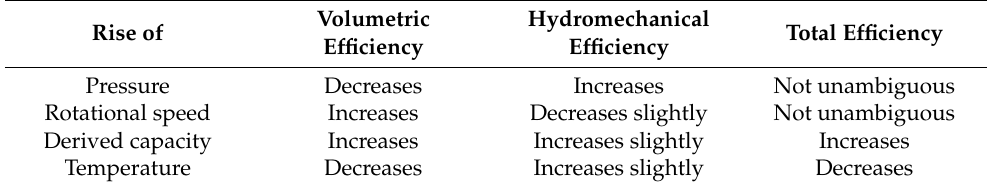
Table 4. Rough generalization of empirical changes in the efficiencies of the studied swash-plate type axial piston pump in relation to the increase in the operating point parameter values. Volumetric Hydromechanical Rise of Total Efficiency Efficiency Efficiency Pressure Decreases Increases Not unambiguous Rotational speed Increases Decreases slightly Not unambiguous Derived capacity Increases Increases slightly Increases Temperature Decreases Increases slightly